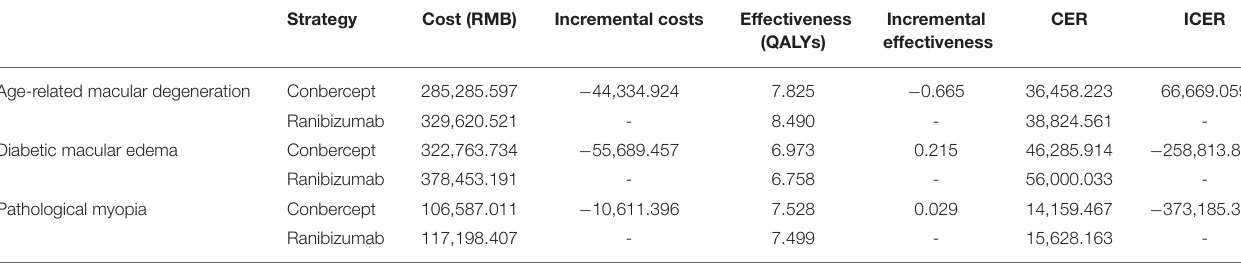
TABLE 6 | The cost-effectiveness analyses of conbercept and ranibizumab in real-world scenario. Strategy